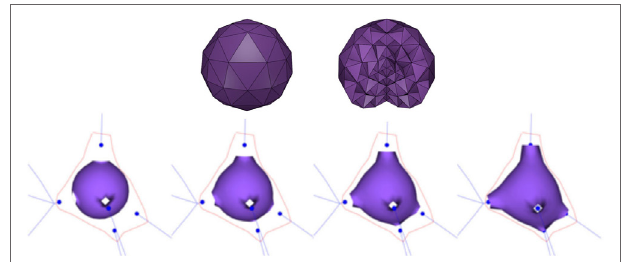
FIGURe 2 | Top images: initial tetrahedral icosphere used in the soma generation process. View of its surface (left image) and of its internal structure (right image). Bottom images: FEM deformation process. During this process, the original icosphere is deformed by forces applied at the dendrites’ insertion points.